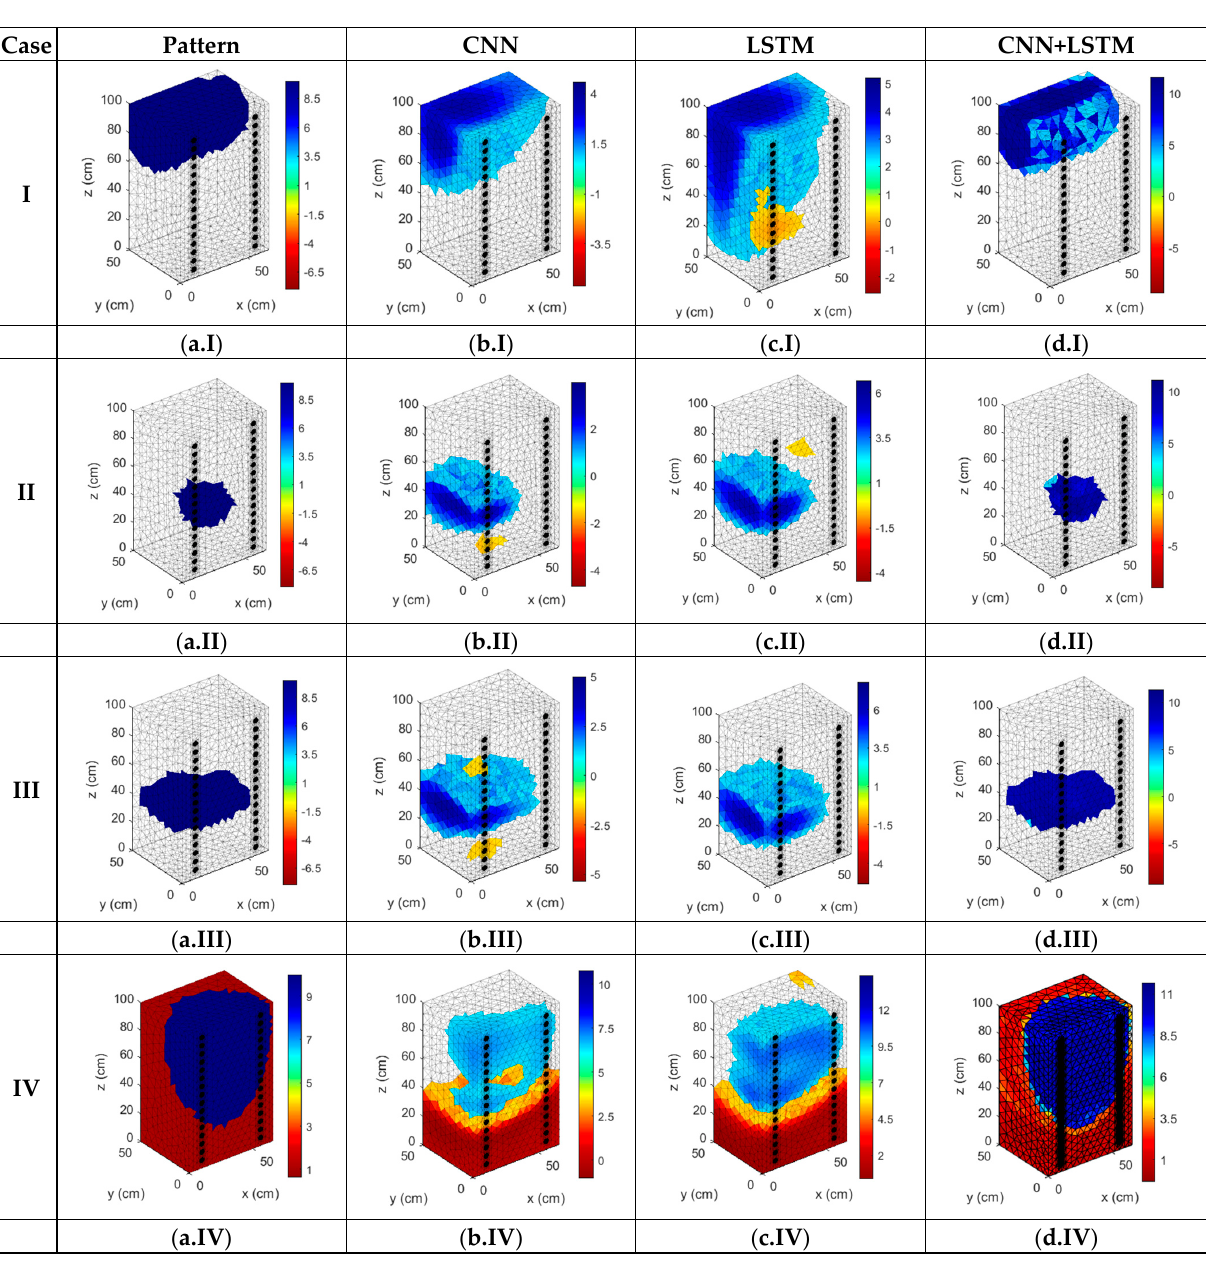
Figure 19. Reconstructions of 4 cases obtained from simulation-generated measurements: ( a.I – a.IV )—pattern images, ( b.I – b.IV )—reconstructions using CNN, ( c.I – c.IV )—reconstructions using LSTM, ( d.I – d.IV )—reconstructions using a hybrid network CNN+LSTM. Table 6. Indicators characterizing the quality of reconstructions for individual methods and variants.